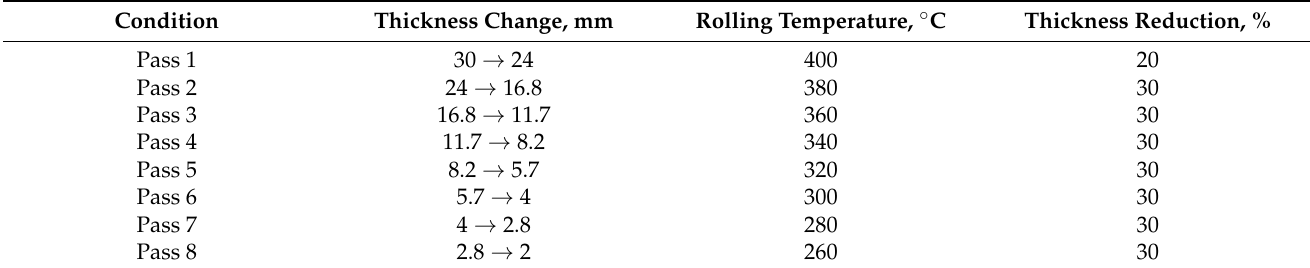
Table 1. Rolling process parameters for AZ31 magnesium